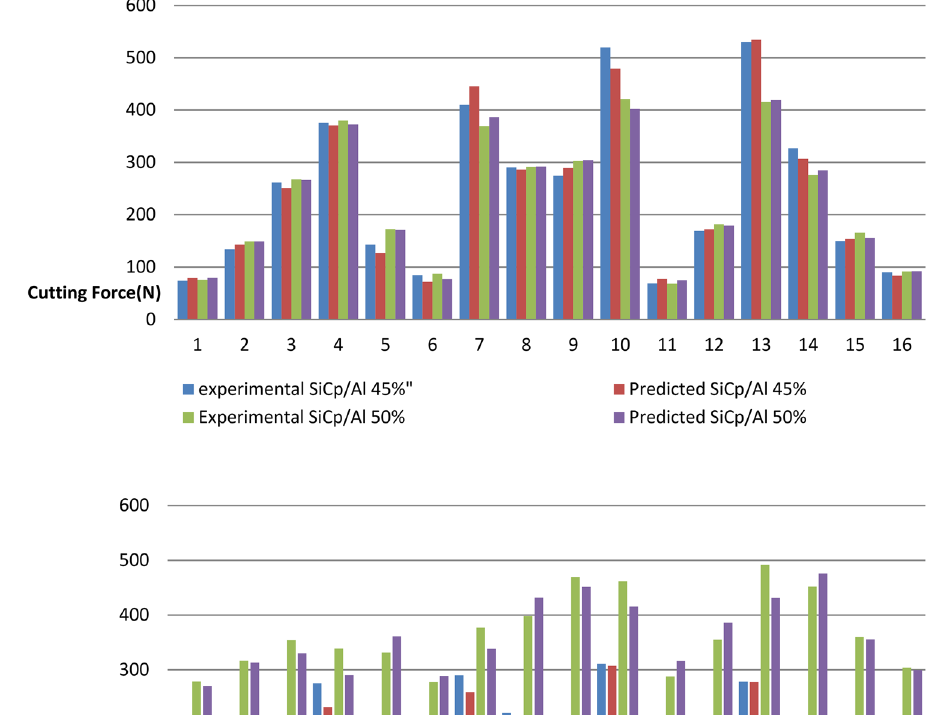
Fig. 24 Comparisons of Experi- ment values and Predicted values of Cutting force of F x , of SiCp/Al 45% and 50%